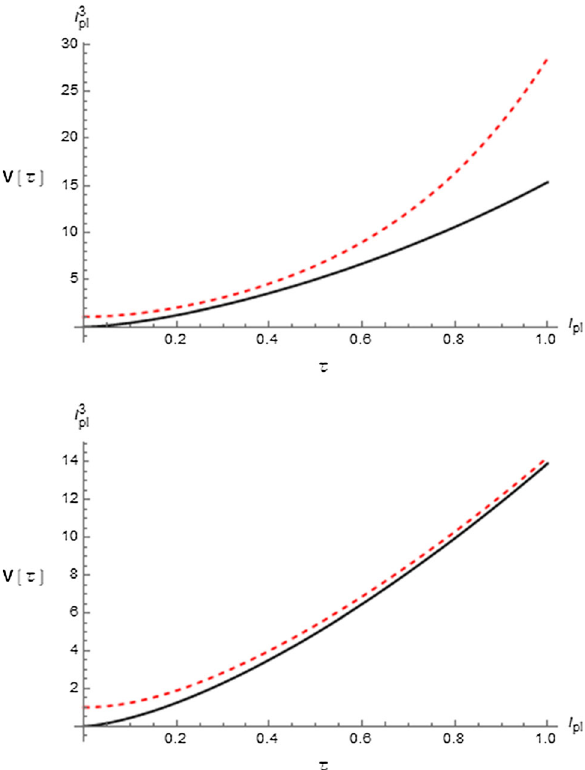
Fig. 5 The figure shows the classical dynamics behavior for a flat Universe (solid line) with Cosmological constant Λ (cid:17)= 0 versus the semi-classical Polymer one (red-dashed line). Two different cases are displayed the one for Λ = 10 − 1 E pl (first picture), and the one for Λ = 10 − 4 E pl . As it can be seen, in the second case the semi-classical dynamics tends to the classical